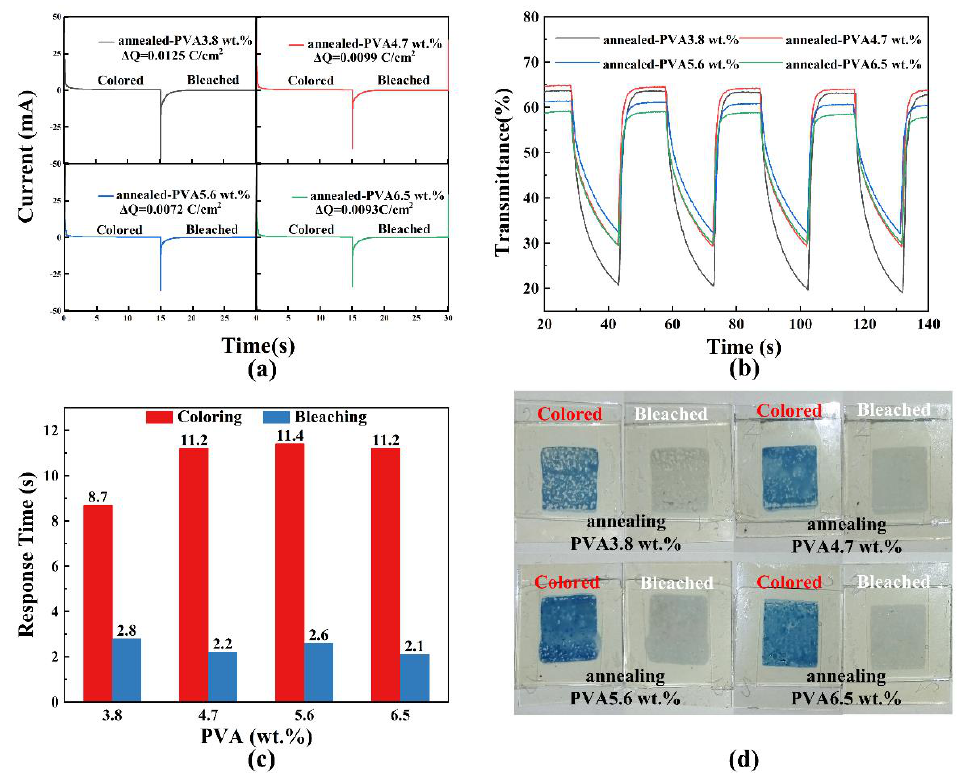
Figure 8. Optoelectronic character of annealed films using the different ink formulas: ( a ) relationship between current and time in one cycle, ( b ) relationship between transmittance and time, ( c ) the coloring/bleaching response time, ( d ) the device photo images. (at 600 nm wavelength).